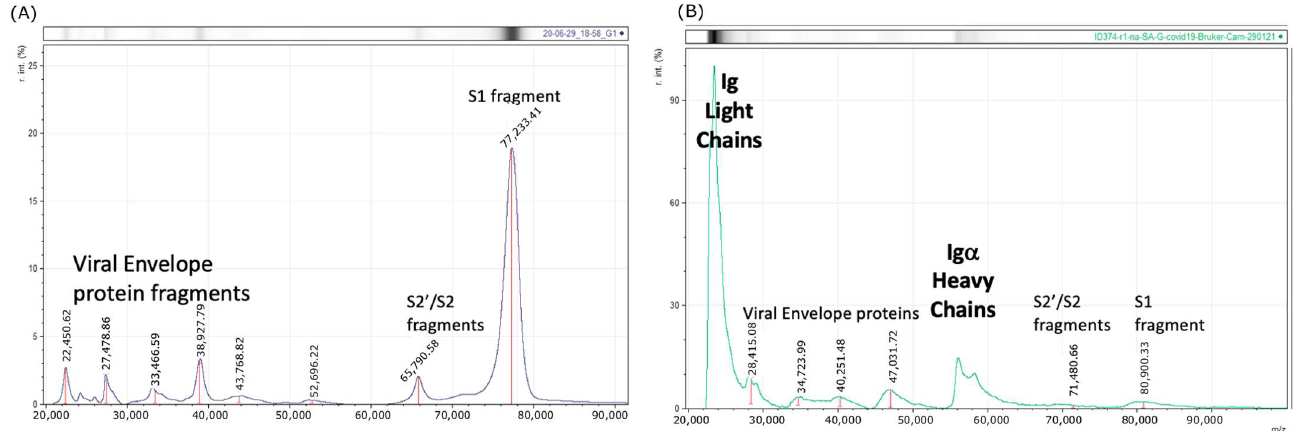
Figure 2. Bruker Biotyper Mass spectral profiles after higher mass drift correction by two-point (H + and 2H + ) calibrating with BSA: ( A ) In Vitro spectra—Culture supernatant, UK isolate of COVID-19 (first wave alpha) grown on HEK293 cells now match with Shimadzu 8020 spectra (Figure 1A—black line). ( B ) Clinical spectra—second wave saliva-gargle from asymptomatic RT-qPCR positive—Male 60’s. S1—Spike protein proteolytic fragment 1; S2—Spike protein proteolytic fragment 2; S2’ Spike protein proteolytic fragment 2’